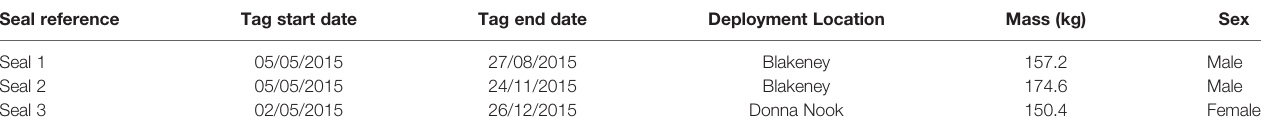
TABLE 1 | Tag deployment